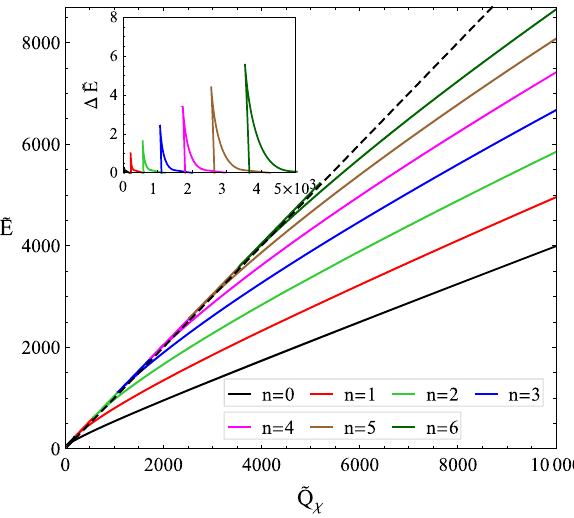
Fig. 8 Dependence of the energy ˜ E of the vortex-Q-ball system on the Noether charge ˜ Q χ for the first few radially excited states. The straight dashed line corresponds to the linear dependence ˜ E = ˜ Q χ . The subplot presents the dependence of the difference Δ ˜ E = ˜ E − ˜ Q χ − ˜ E v on ˜ Q χ in neighbourhoods of cuspidal